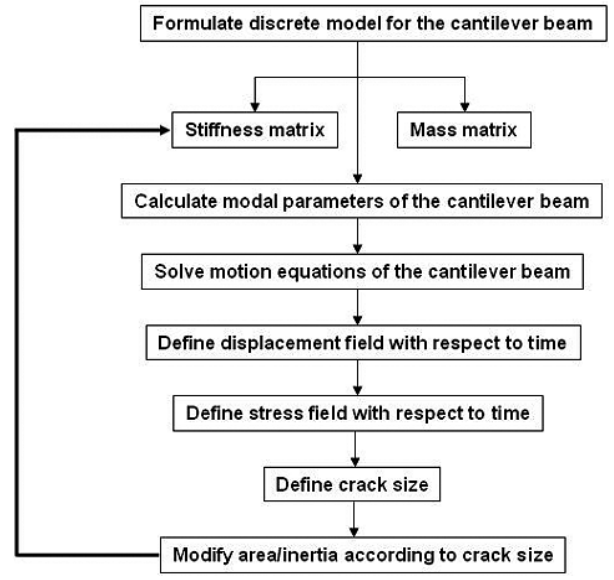
Fig. 4. Flowchart of numerical scheme to couple the vibration and degradation phenomena.